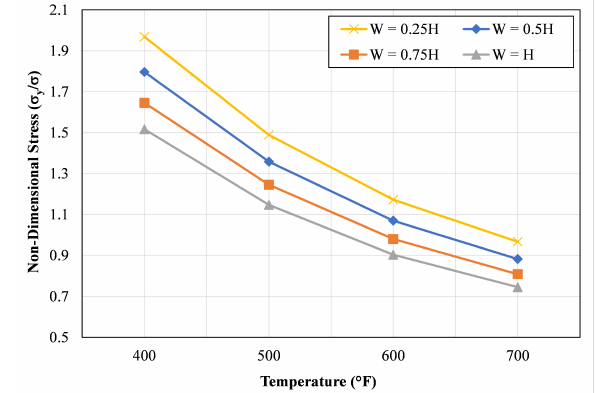
Figure 12: Relationship between σ y / σ on the expansion loop pipe 24-inch diameter with increasing